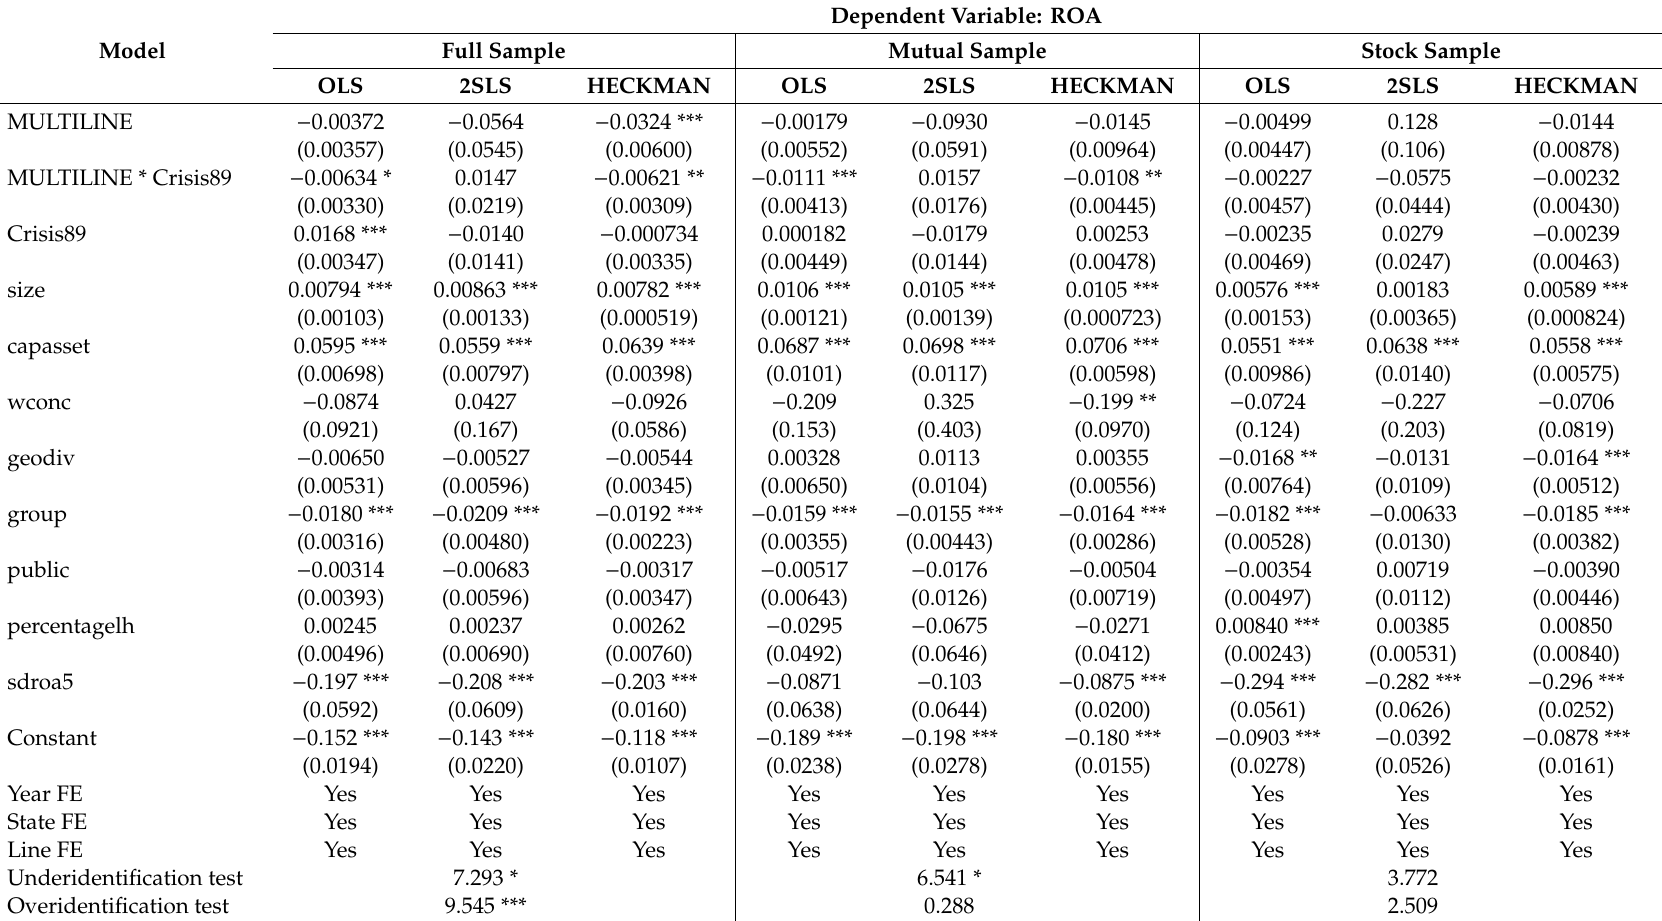
Table 4. Diversification E ff ect on Performance (ROA), Mutual vs.